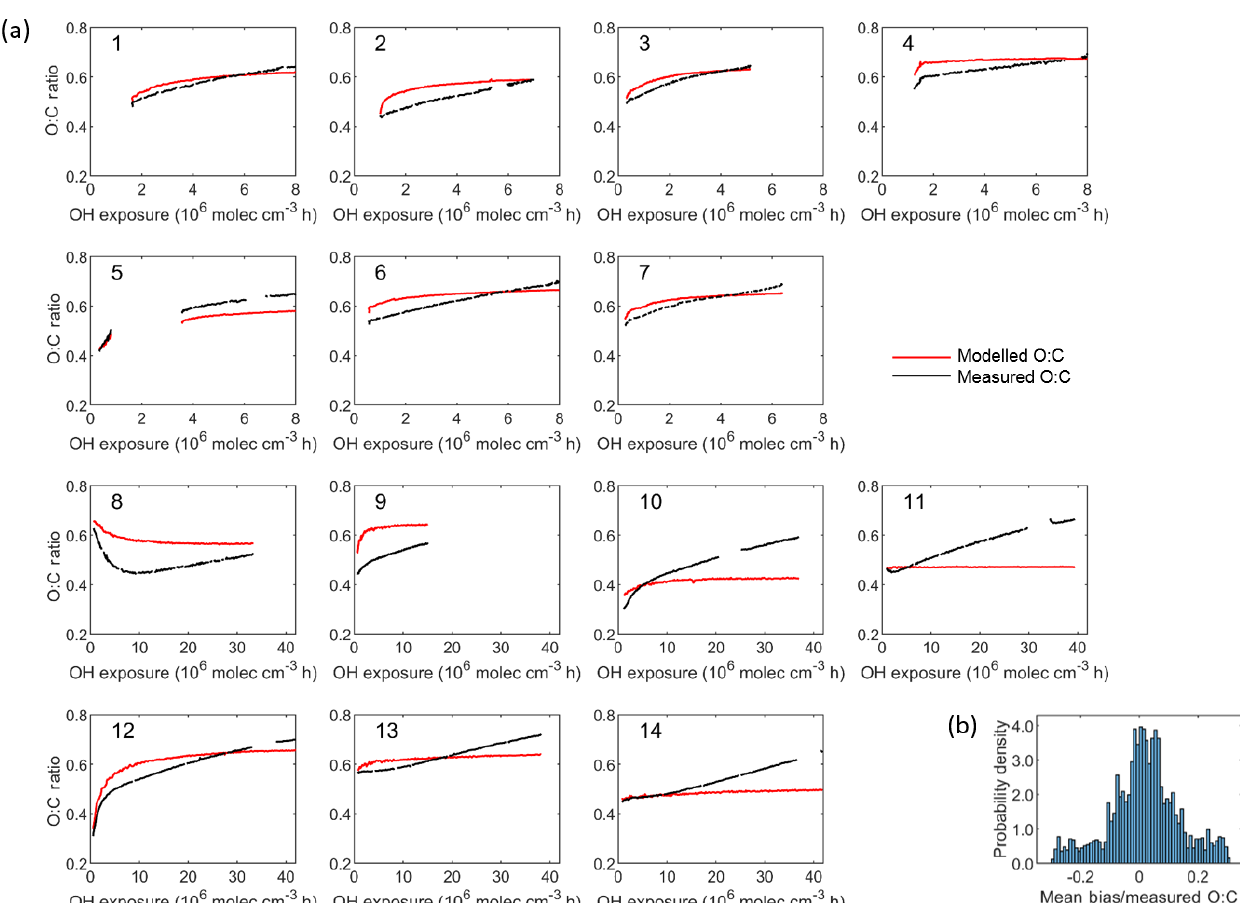
Figure 8. (a) Comparison between modelled and measured O:C ratio as a function of the OH exposure for each experiment. Set 1 (Expt. 1–7, 2 ◦ C) and Set 2 (Expt. 8–9, − 10 ◦ C and Expt. 10–14, 15 ◦ C). (b) Probability distribution of the relative bias (normalized by the averaged measured O:C ratios). The resulting mean relative bias is 0.006 and the root-mean-square error (RMSE) is